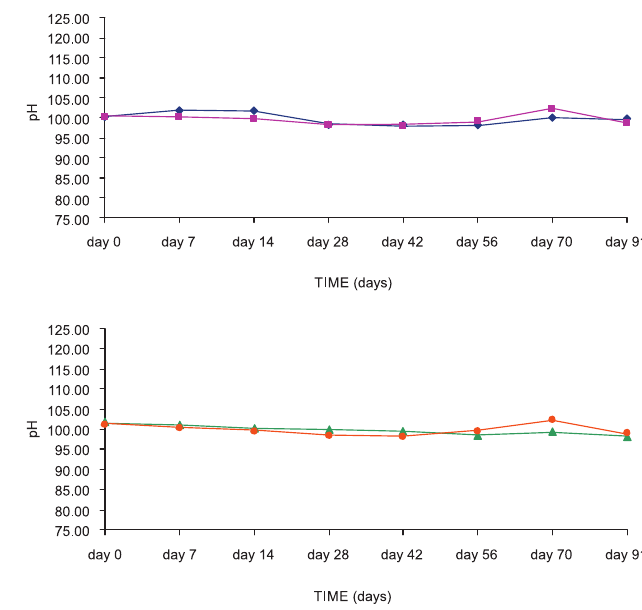
FIGURE 5 - Sildenafil citrate content (%) variation on syrup solutions (mean ± standard deviation; n = 3).  preservative-free solution stored at 5ºC ± 3ºC and  stored at 25 ºC ± 2 ºC/60% RH ± 5% RH  solution containing preservative stored at 5 ºC ± 3 ºC and  stored at 25 ºC ± 2 ºC/60% RH ± 5%